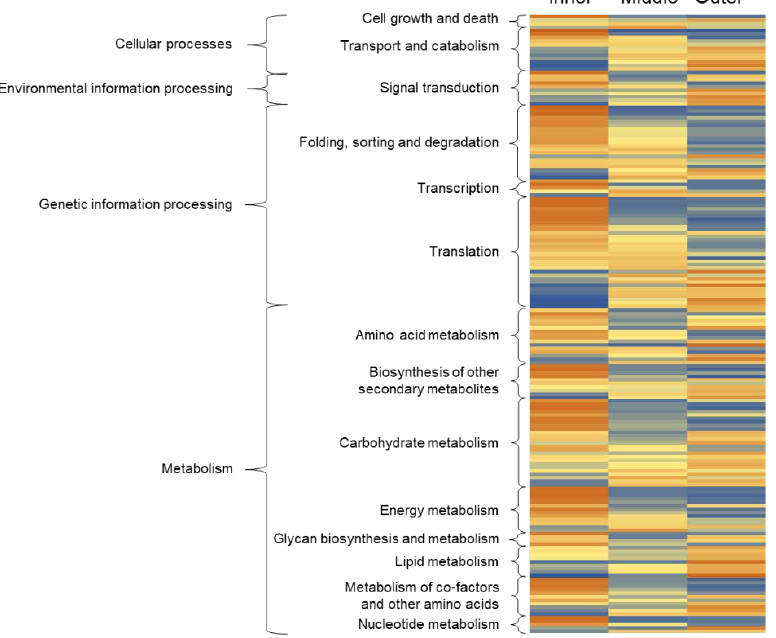
Figure 4. Heatmap depicting differentially abundant proteins that were identified by the label-free proteome analysis. Colors represent the normalized relative protein abundance ranging from zero (dark blue) to 300 (dark orange) for one protein across the different tissues. Functional annotation was performed based on KEGG pathways. Further information related to protein accession numbers, KEGG pathway ID and significance testing is provided in Table S2.